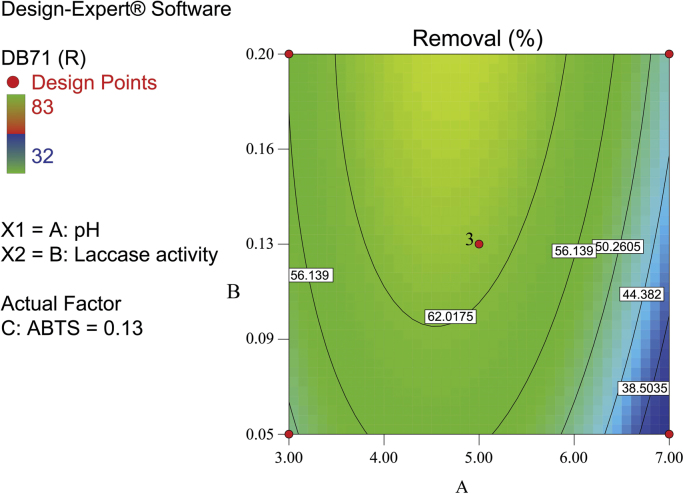
Contour plot of the interaction effects of pH (A) and laccase dose (B) on DB71 removal.